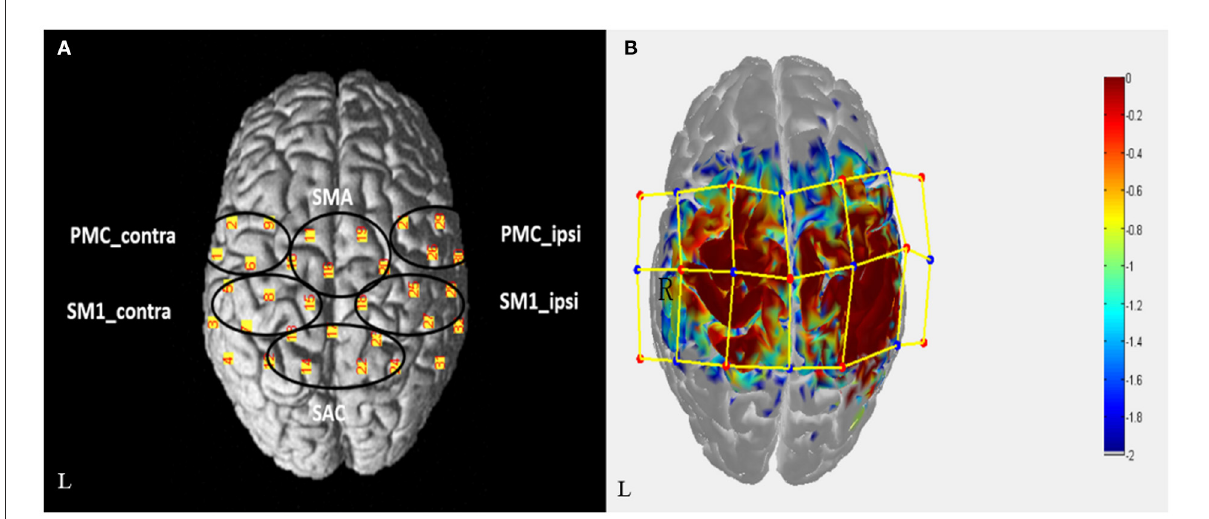
FIGURE3 (A) The arrangement map of fNIRS channels in the cortex, which is divided into 6 ROIs. (B) Light sources (red dot, 11) and detectors (blue dot, 10) forming 32 channels (yellow line). The sensitivity distribution map of photons in the cortex is simulated by Monte Carlo, and the redder the region is, the stronger the sensitivity